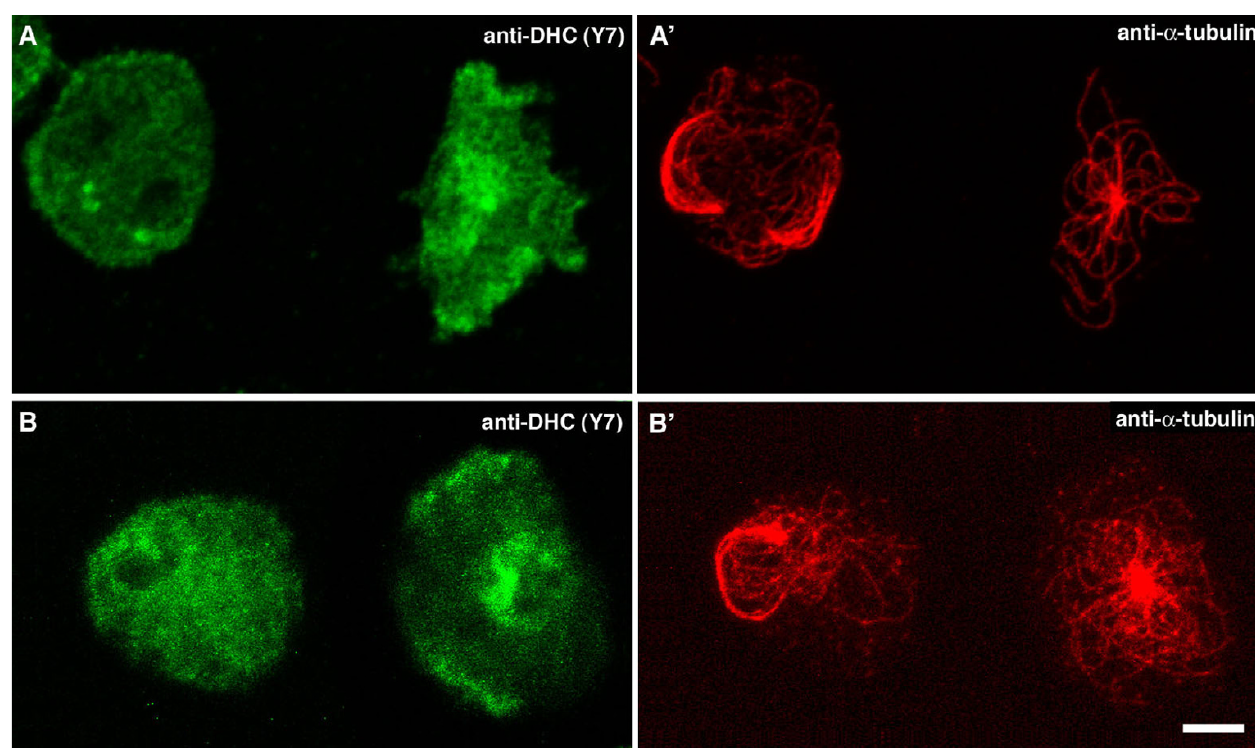
Figure 4 Cells with disrupted microtubule arrays show reduced cortical localization of dynein. Confocal microscopy of DdCP224- ∆ C-GFP cells showing brightest point projections of immunofluorescence stainings using anti-dynein-Y7 [19] (A, B) and and the YL1/2 anti-tubulin antibody (A', B'). In both examples, the left cell exhibits a disrupted microtubule array and is characterized by reduced cortical distribution of the dynein heavy chain compared to the right cell which shows normal micro- tubules. Cells were fixed with formaldehyde/acetone. Bar 2 µ